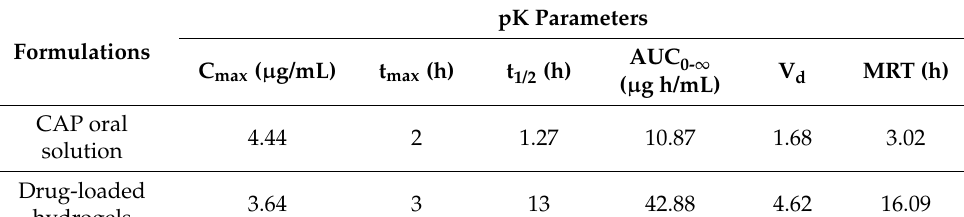
Table 6. Pharmacokinetic parameters of pure drug and drug-loaded polymeric network.